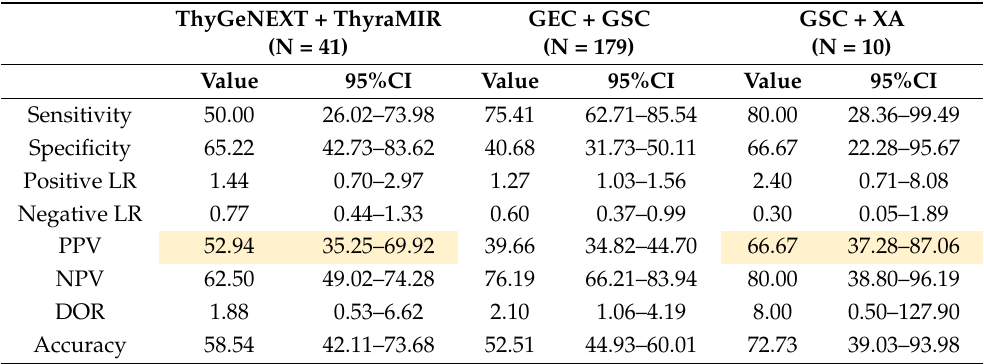
Data are present for value and 95% confidence interval (lower limit—upper limit). A gold highlight indicates a superior genetic testing platform for that diagnostic parameter. LR: likelihood ratio; PPV: positive predictive value; NPV: negative predictive value; DOR: diagnostic odds ratio; CI: confidence